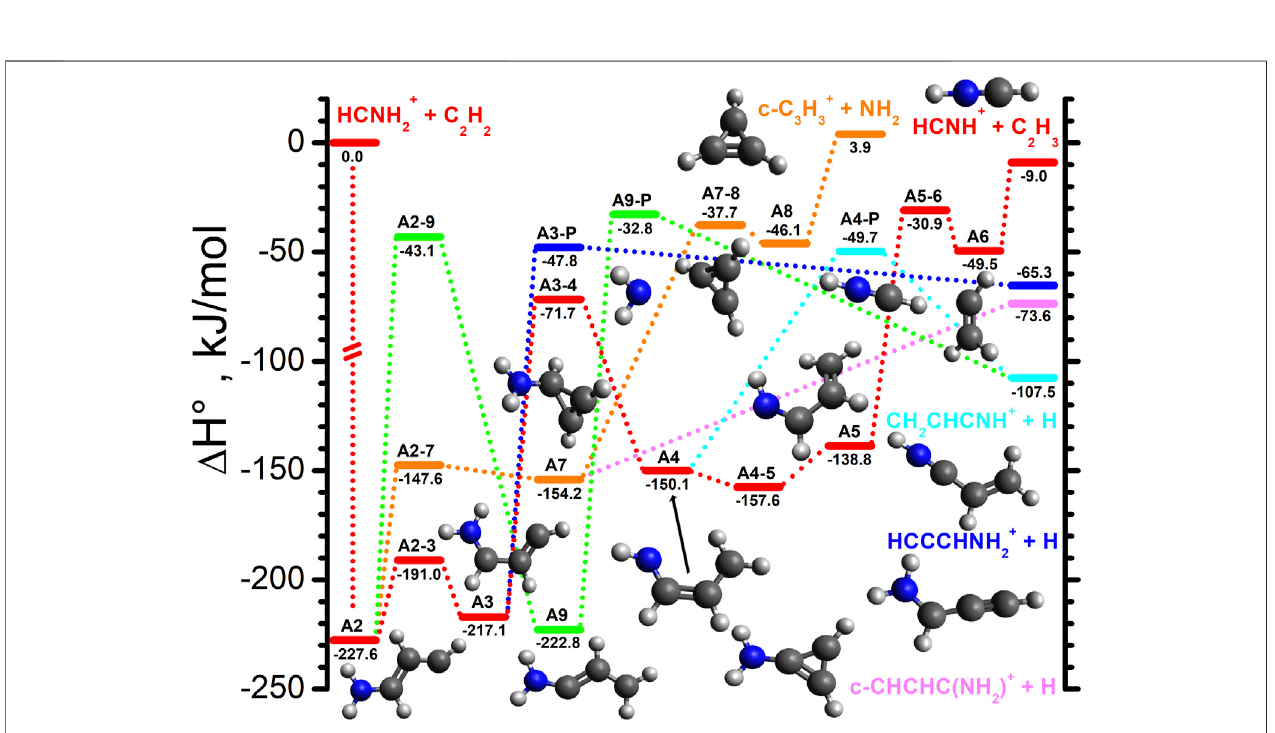
FIGURE 7 | Energies and reaction pathways for the HCNH 2+ (cid:129) plus C 2 H 2 . Energies (in kJ/mol) are de fi ned with respect to the separated HCNH 2+ (cid:129) plus C 2 H 2 reactants. Calculations are at the MP2/6-311++G (d,p)//CCSD(T)/6-311++G(d,p) level of theory. Molecular structures are shown only for intermediates and products. For TSs ’ structures see the Supplementary Material